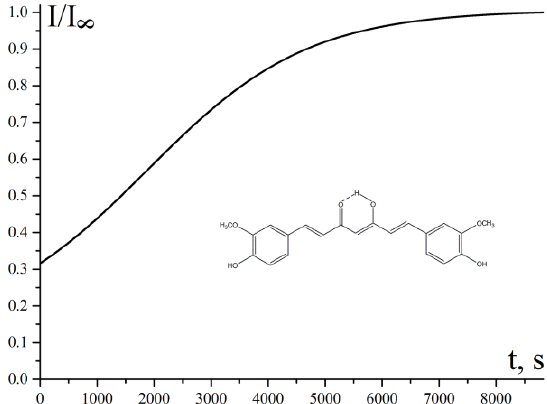
Figure 4. Time profiles of the relative CL intensity (I/I ∞ ) measured during the oxidation of ethylbenzene in the aerated chlorobenzene solution (26% vol.) initiated by AIBN at the rate of R IN = 5.1 × 10 –9 M s − 1 and 50 °C upon introduction of 1.2 × 10 − 5 M of curcumin. Table 4. The values of the effective rate constant ( k A ) of scavenging the peroxyl radicals of ethylbenzene by antioxidants.